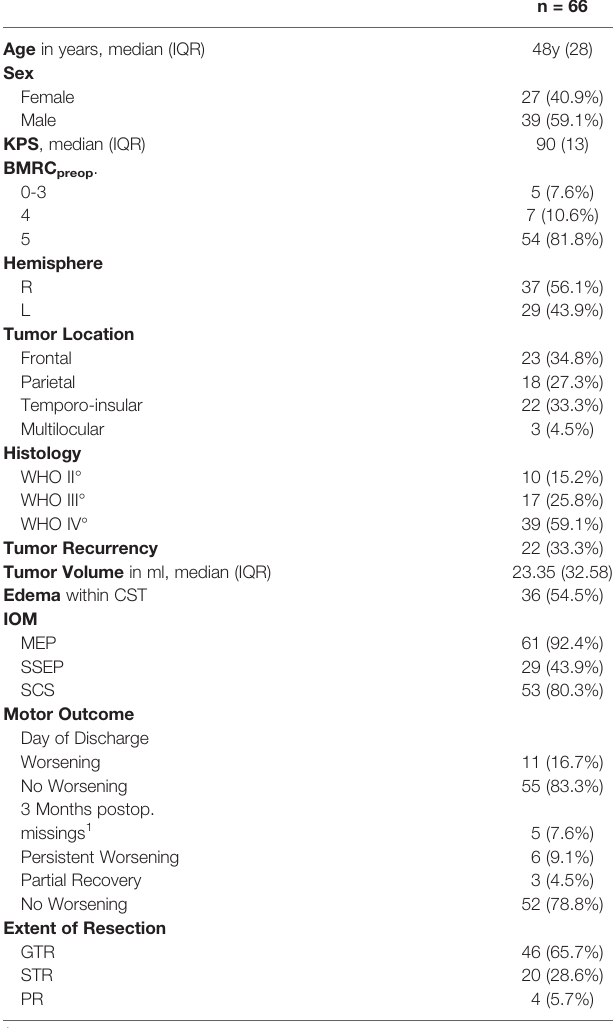
TABLE 1 | Patient